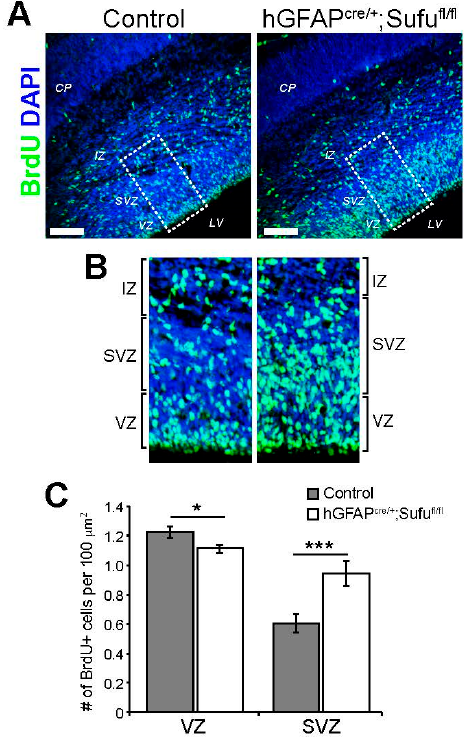
Figure 2. Abnormal proliferation of cortical progenitors in the E16.5 hGFAP cre/+ ;Sufu fl/fl neocortex; ( A , B ) Immunofluorescence staining with anti-BrdU showed that after 4 h of BrdU-treatment, BrdU+ cells were greater in the E16.5 hGFAP cre/+ ;Sufu fl/fl neocortex compared to control littermates ( A ); Boxed areas in ( A ) showed that this increase was apparent in the SVZ of the E16.5 hGFAP cre/+ ;Sufu fl/fl neocortex ( B ); Scale bars = 100 µ m; CP, cortical plate; BrdU, 5-bromo-2-deoxyuridine ( C ) Quantification of BrdU+ cells within the VZ were mildly, yet significantly reduced, in the E16.5 hGFAP cre/+ ;Sufu fl/fl neocortex. In contrast, a significant increase in the density of BrdU+ cells were quantified in the SVZ of the E16.5 hGFAP cre/+ ;Sufu fl/fl neocortex compared to controls; * p -value < 0.05, *** p -value <